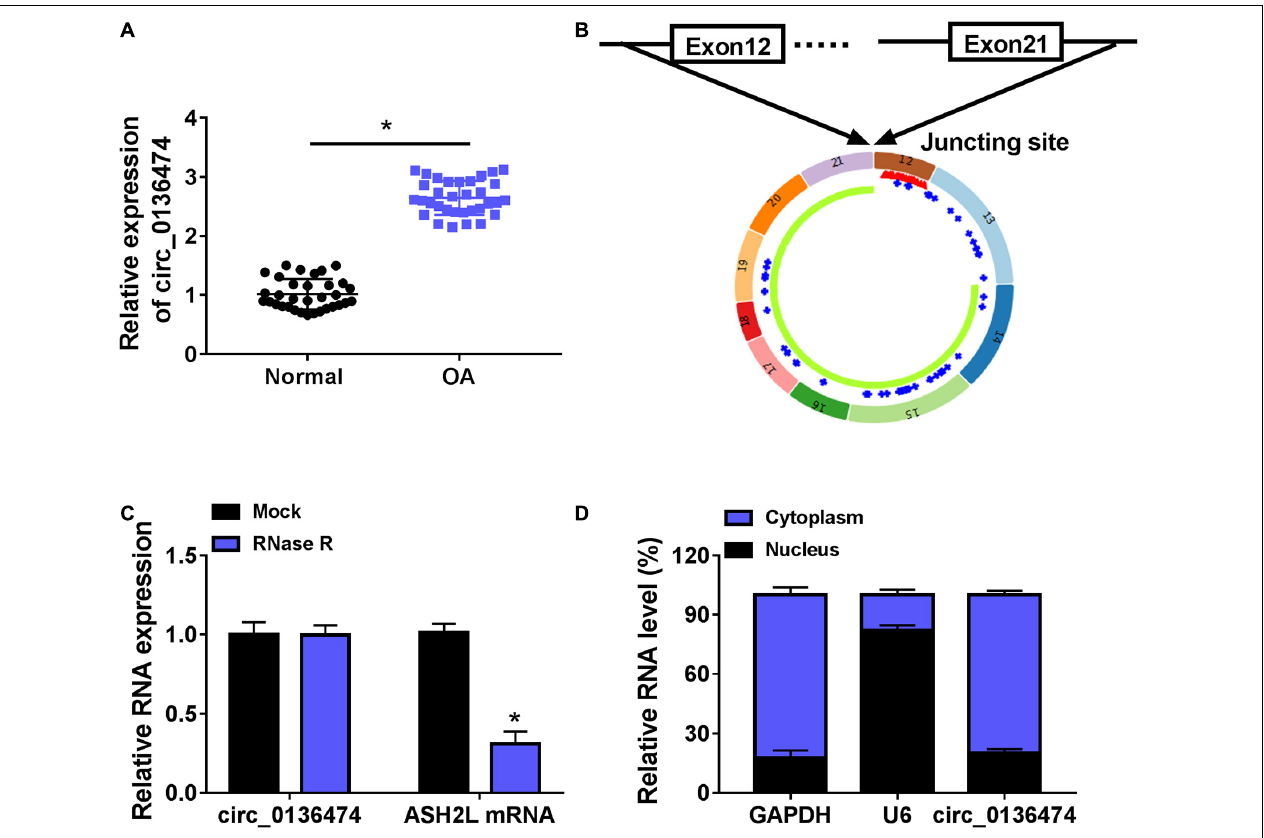
FIGURE 1 | Circ_0136474 was an upregulated circRNA in osteoarthritis (OA) patients. (A) Quantitative real-time (qPCR) detected relative expression of circ_0136474 in OA cartilages ( n = 33) and normal cartilages ( n = 33). (B) Schematic diagram showing the junction site of exons 12–21 of ASH2L. (C,D) qPCR compared the relative RNA expression levels of circ_0136474, ASH2-like histone lysine methyltransferase complex subunit (ASH2L), glyceraldehyde-3-phosphate dehydrogenase (GAPDH), and U6 in human CHON-001 chondrocytes. * P < 0.05 was determined by two-way ANOVA or unpaired t -test.